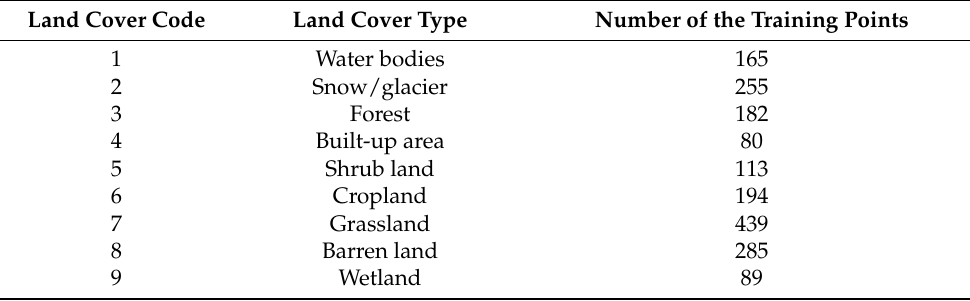
Table 1. Classification system and list of training